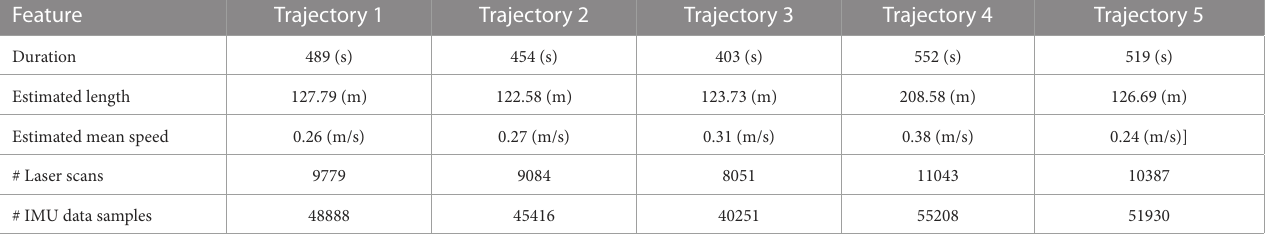
TABLE3 Informationaboutthefivetrajectoriesoftheoutdoorexperiment.Thefirstoneisusedtobuilda3DmapoftheenvironmentusingSLAM,whiletheother allowstoevaluatethelocalizationalgorithms.